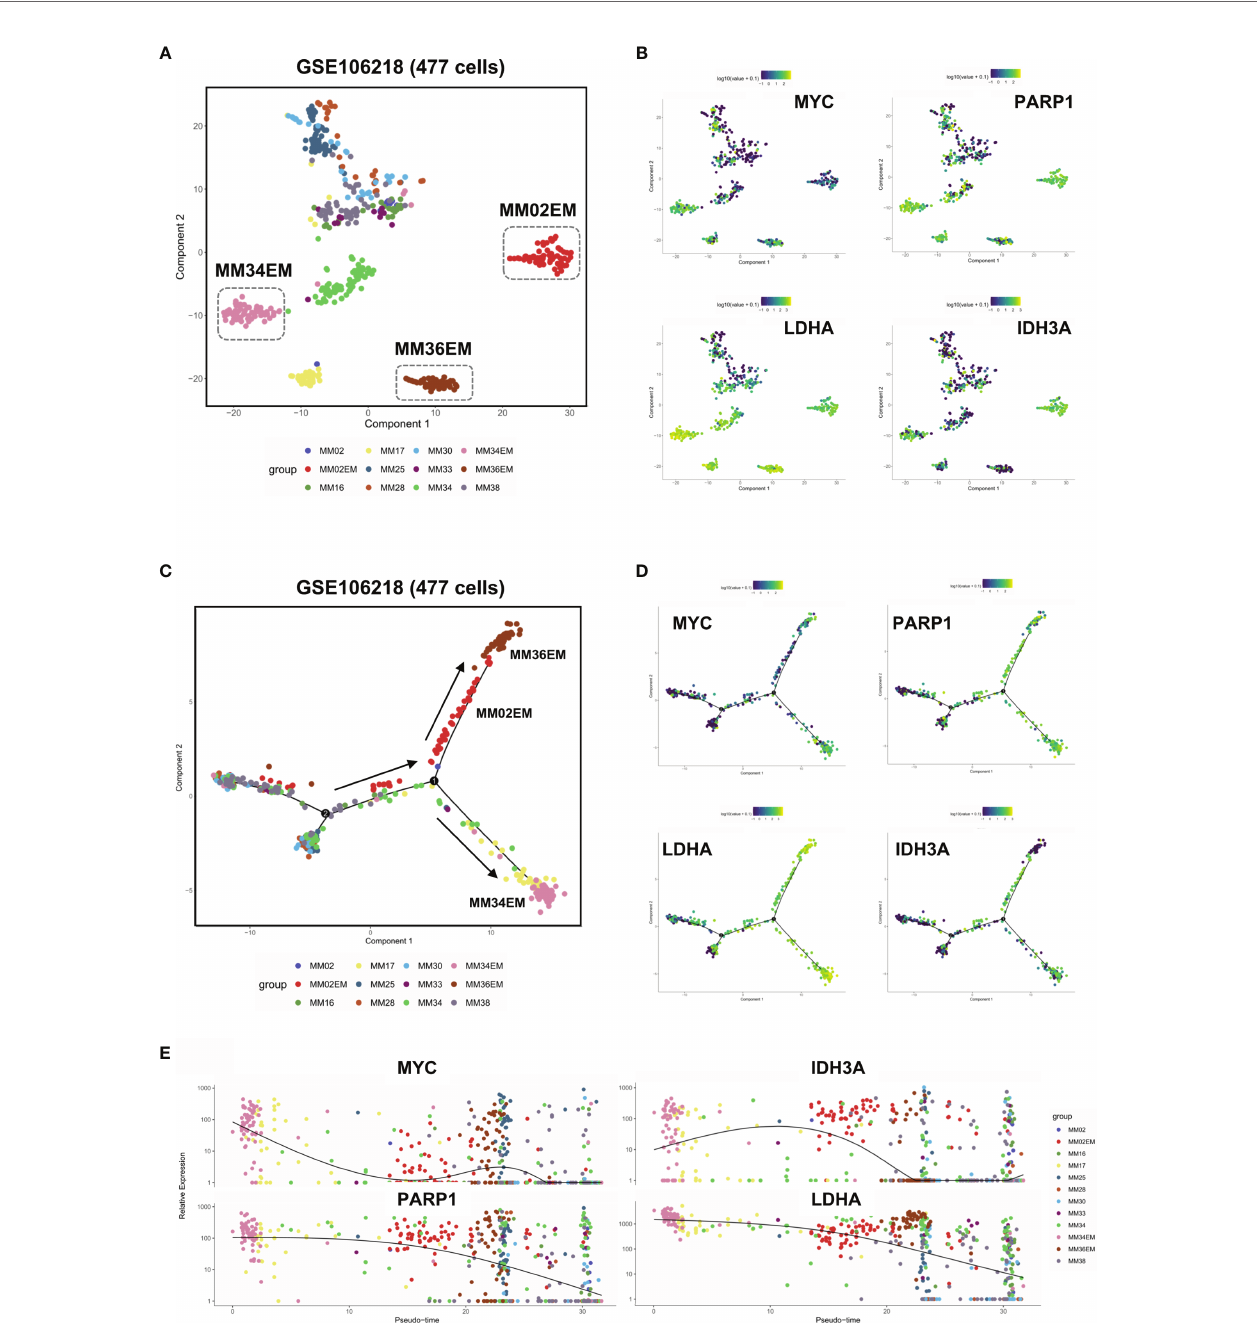
FIGURE 5 | Dysregulated DNA repair process and metabolic reprogramming in Group 1 MM facilitated extramedullary invasion. (A) tSNE plots of 447 single-cell transcriptome data of primary and extramedullary MM samples based on the GSE106218 dataset. (B) The distribution and intensity of the expression of MYC/PARP1/LDHA/ IDH3A on tSNE plots. (C) Pseudo time analysis of 447 single-cell transcriptome data via Monocle algorithm. Arrows indicated evolutionary directions. (D) The distribution and intensity of the expression of MYC/PARP1/LDHA/IDH3A on Monocle plots. (E) The expression intensity of MYC/PARP1/LDHA/IDH3A along pseudo time